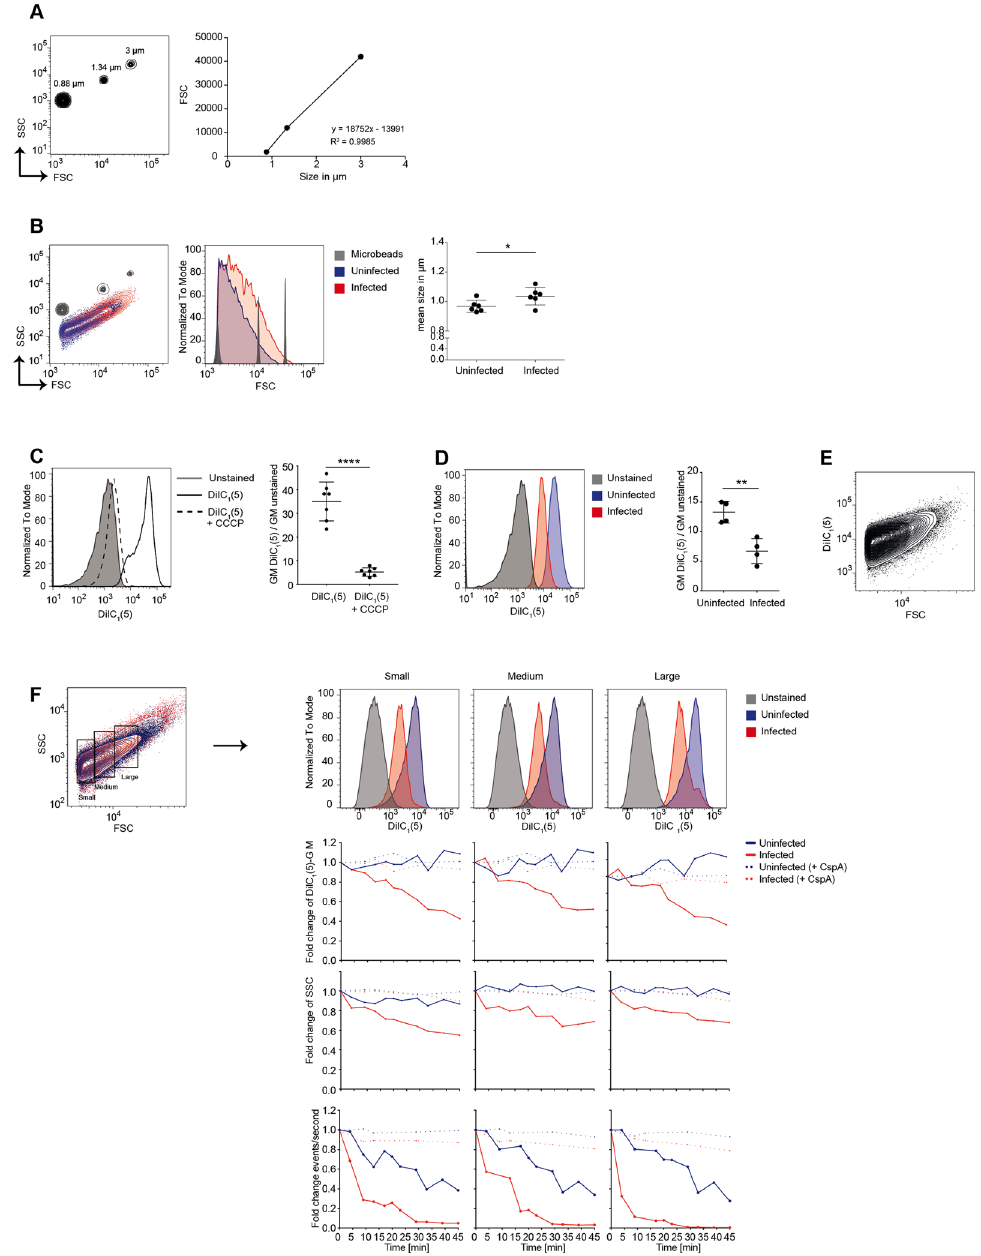
Figure 2. Specific determination of size, membrane potential and stress response of mitochondria from infected hepatocytes. ( A ) Flow cytometric analysis of size beads (0.88, 1.34 and 3 µ m) from sperotech. Geometric mean (FSC) is plotted against corresponding size to calculate linear equation. ( B ) Flow cytometric analysis and quantification of purified mitochondria isolated from uninfected and Ad-CMV-GOL-infected mice (5 × 10 8 pfu/mouse) mixed with sperotech size beads. Mean size in µ m was calculated using linear equation calculated before ( A ). Six independent experiments were used for statistical analysis. ( C ) Flow cytometric analysis and quantification of mitochondrial membrane potential of isolated liver mitochondria using the membrane-potential dependent dye DilC 1 (5). Breakdown of mitochondrial membrane potential induced by CCCP (5 µ M) observed by loss of DilC 1 (5) staining. Seven independent experiments were used for statistical analysis. ( D ) Flow cytometric analysis and quantification of the membrane potential by DilC 1 (5) staining of purified mitochondria from uninfected and Ad-CMV-GOL infected livers (as in ( B )). Four independent experiments were used for statistical analysis. ( E ) Flow cytometric analysis of purified liver mitochondria for the membrane potential dye DilC 1 (5) (100 nM) against FSC. ( F ) Flow cytometric analysis at indicated time points after challenge with calcium of purified mitochondria isolated from uninfected and Ad-CMV-GOL-infected livers (as in ( B )). Mitochondria were stained with DilC 1 (5) and challenged with 100 µ M calcium with or without Cyclosporin A (5 µ M); fold change in DilC1(5) geo-mean, SSC and events/second were plotted against time. Unless stated otherwise, data are representative from at least three independent